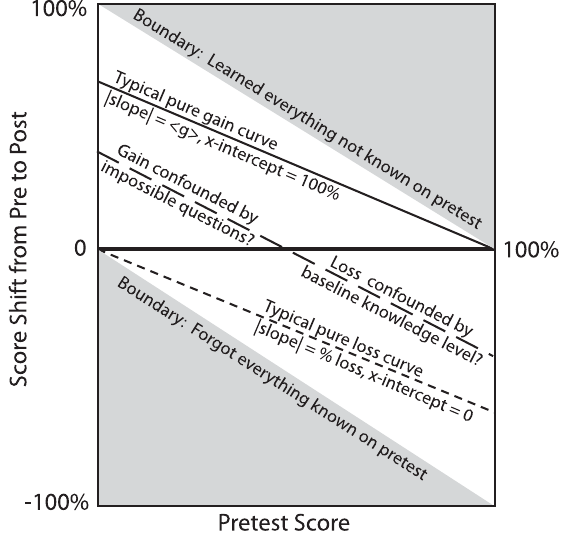
FIG. 1. The solid line represents a pure gain curve because it has its pretest score axis intercept at 100%. The absolute value of the slope of the gain curve is equal to the average normalized gain. The dotted line is a pure loss curve because it has its pretest score intercept at 0%. The absolute value of the slope of the loss curve is equal to the average fraction of knowledge lost. The dashed line is a sample linear fit to a data set which is neither pure loss nor pure